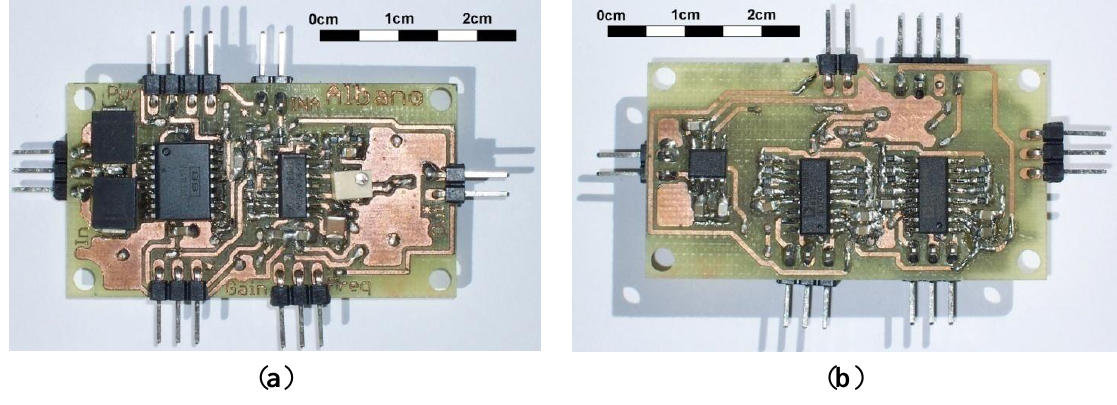
Table 1. Cut-off frequencies (Hz) for each G and R